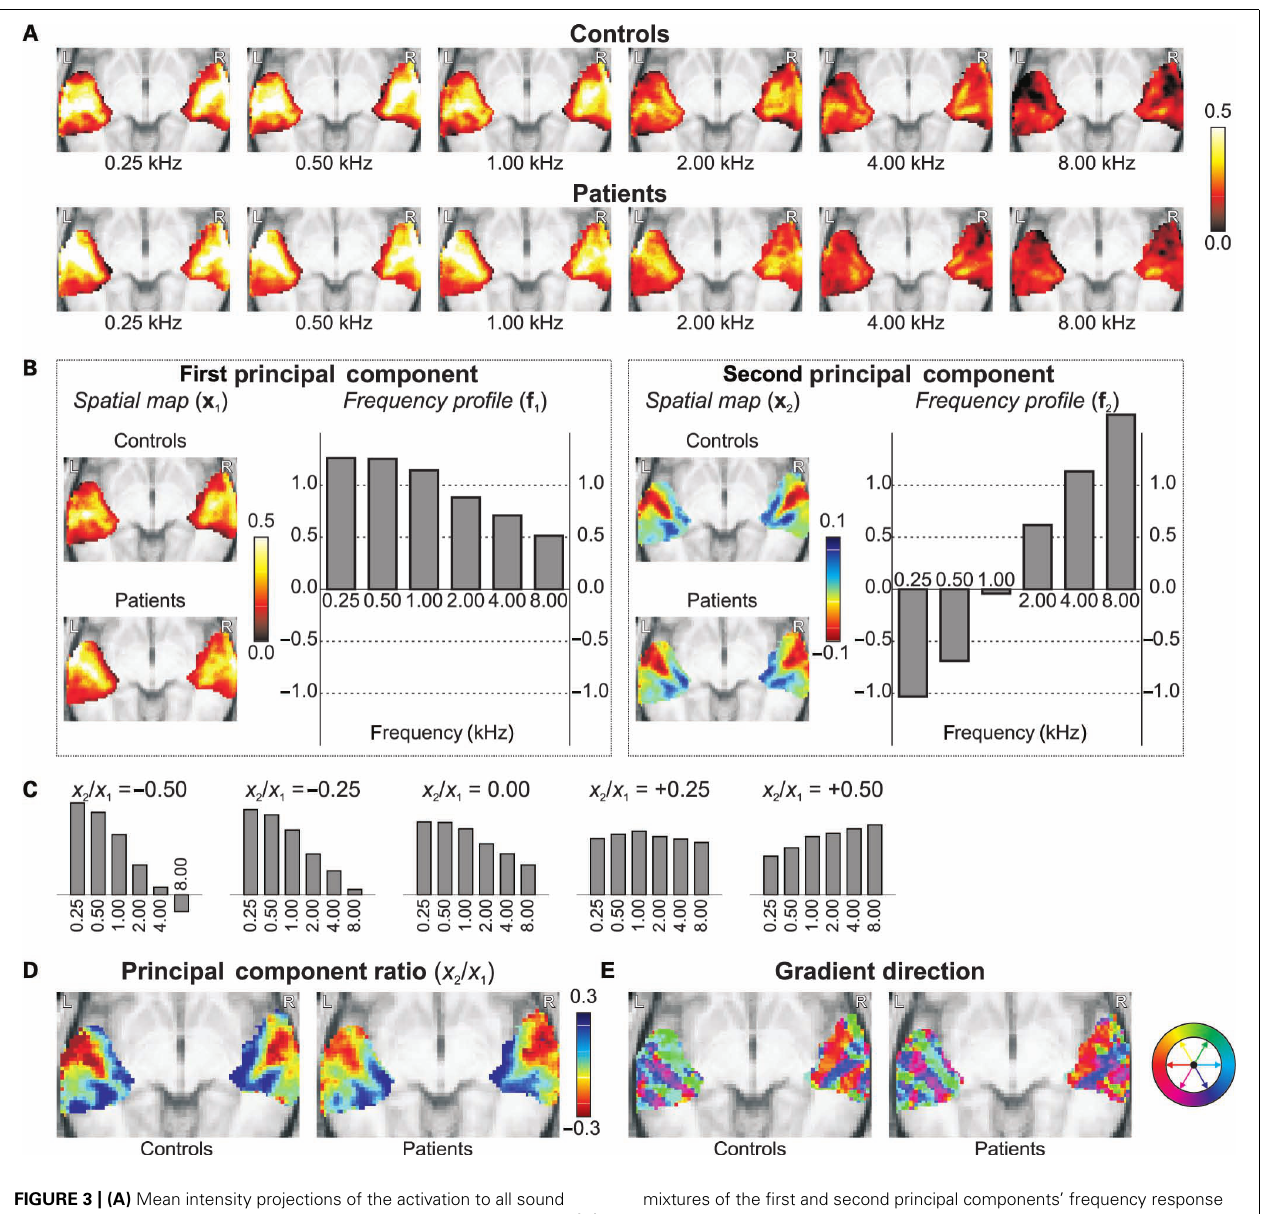
FIGURE 3 | (A) Mean intensity projections of the activation to all sound stimuli (interpolated to 40 dB HL) in the controls and patients separately. (B) A principal component decomposition of the frequency-dependent response profiles across all voxels and all subjects resulted in a first component that summarized the general activation levels, and a second component that reflected the frequency-selectivity that differed between voxels. (C) For various